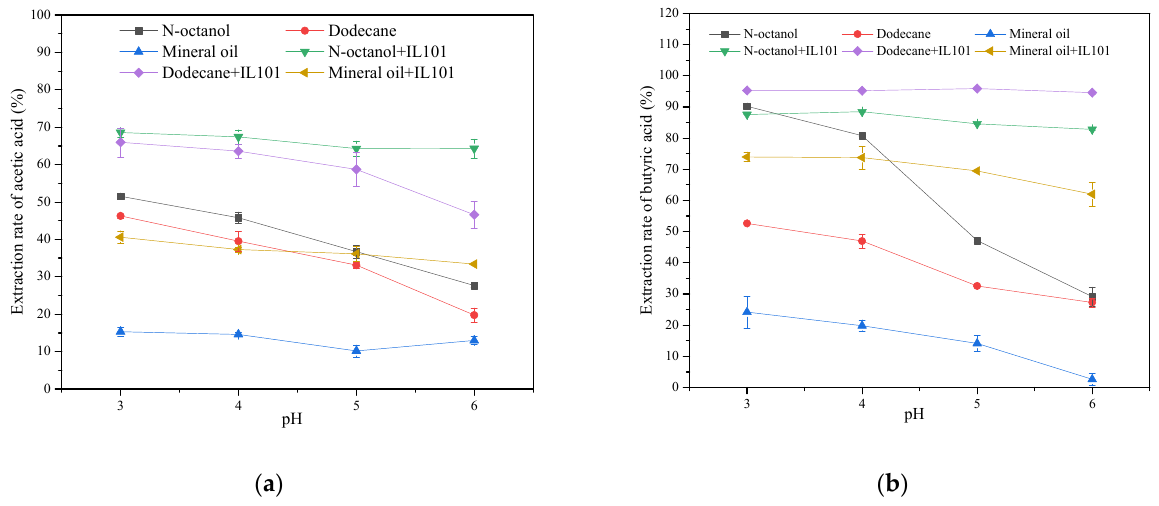
Figure 2. Extraction rates of acetic acid ( a ) and butyric acid ( b ) using IL 101 with different diluents. As shown in Figure 2b, all diluents could extract butyric acid without IL addition. n ‐ octanol, dodecane, and mineral oil decreased from 90.3 ± 0.2%, 52.7 ± 0.2%, and 24.2 ± 5.1% at pH 3 to 29.2 ± 3.0%, 27.3 ± 1.4%, and 2.6 ± 1.9% at pH 6, respectively. After adding